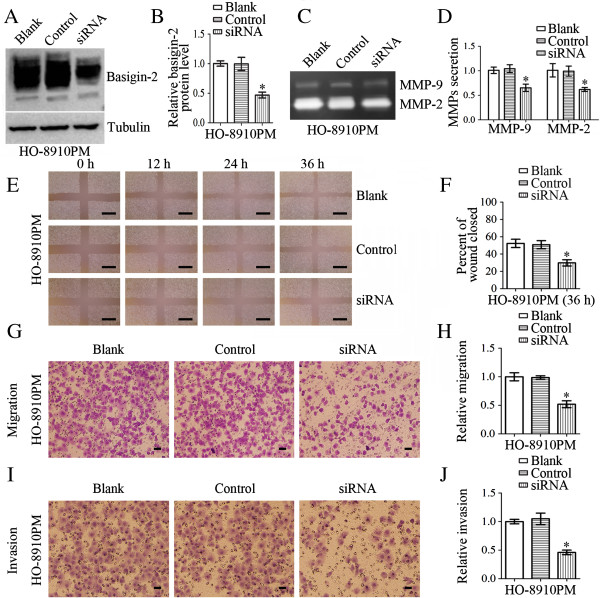
Effects on cellular invasiveness/migration and MMP-9/MMP-2 expressions of HO-8910PM cells after transfection with basigin-2 siRNA. HO-8910PM cells were either untransfected (blank), or transfected with nonspecific siRNA (control) or basigin-2 siRNA (siRNA). A-B Western blot demonstrated basigin-2 protein levels were significantly inhibited by basigin-2 siRNA. C-D HO-8910PM cells were incubated for 24 h and conditioned media were used for the measurement of MMP-2 and MMP-9 protein levels by gelatin zymography. Zymographic analysis showed decreased MMP-2 and MMP-9 activity in HO-8910PM cells transfected with basigin-2 siRNA. E-F Wound healing assay was performed on monolayers of HO-8910PM cells transfected with basigin-2 siRNA. The wound gaps were measured at six reference points along the wound, and the results were expressed as the average wound gap. G-H Suppression of basigin-2 expression in HO-8910PM cells resulted in significant reduction in cellular migration. I-J Suppression of basigin-2 expression in HO-8910PM cells resulted in significant reduction in cellular invasiveness. Scale bars = 0.5 mm (E). Scale bars = 0.1 mm (G, I). Statistical significance was assessed using one-way ANOVA. Data are presented as mean ± SD for three independent experiments. *P < 0.05, statistically significant difference.